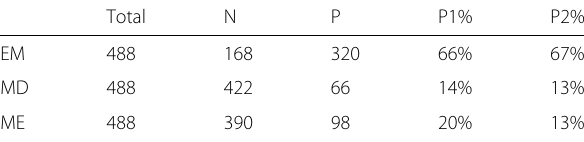
Table 1 The number of positive and negative instances in the data sets of the three attack types